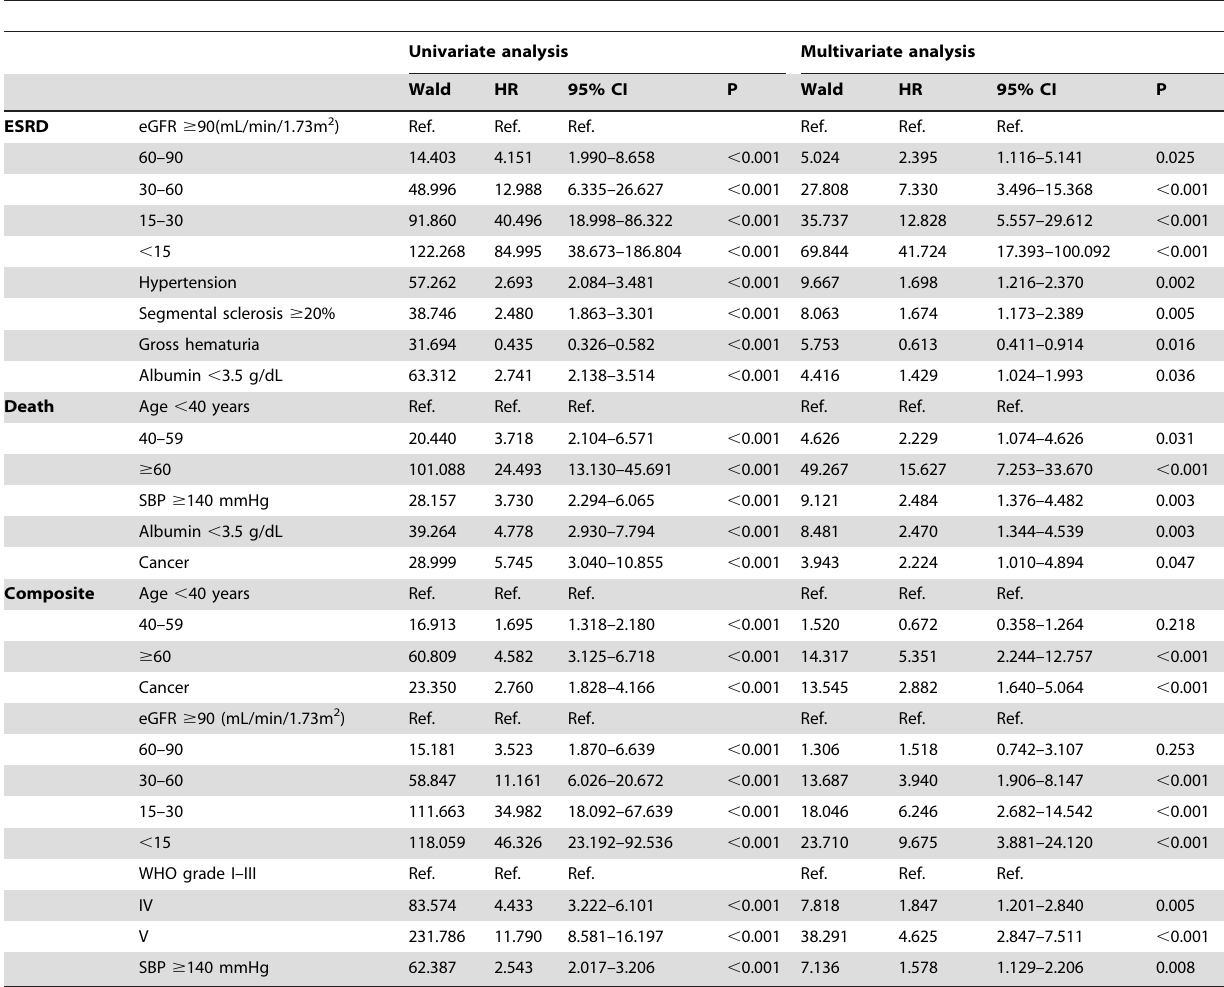
Table 3. Univariate and multivariate time dependent cox regression analyses for patient death and renal